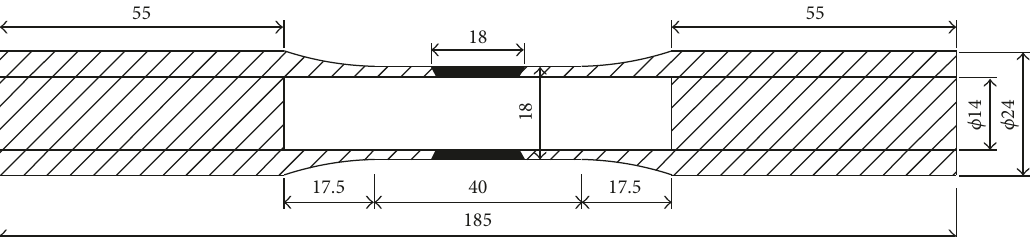
Figure 15: Geometry of the welded metal specimen (unit: mm).